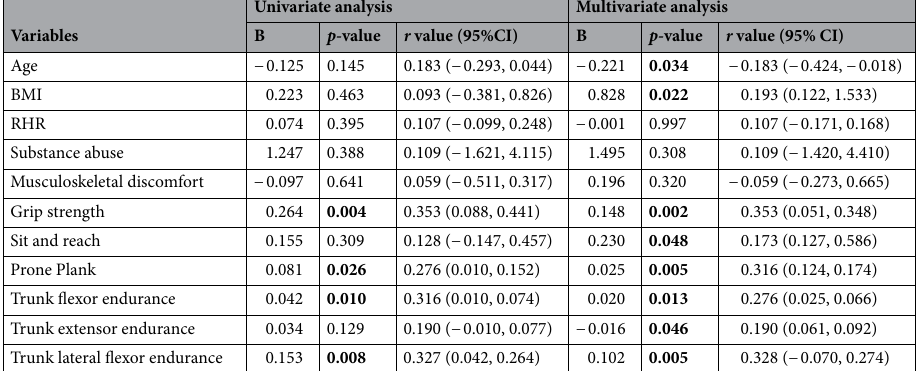
Table 2. Factors analyzed while developing lifting capacity prediction model (n = 65). Significant values are in